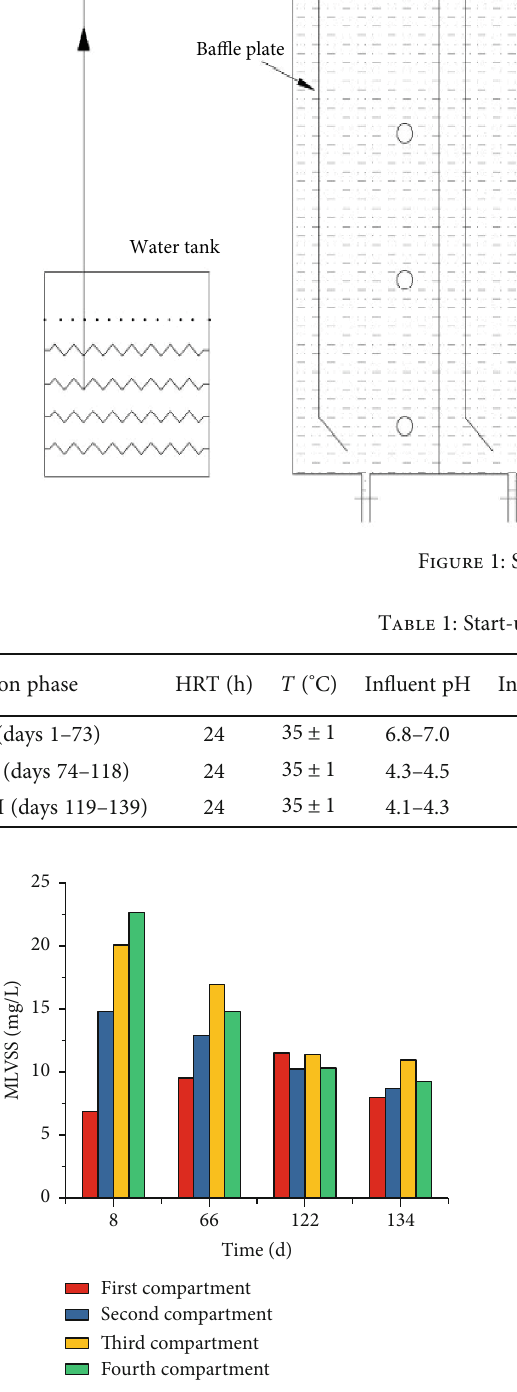
Figure 2: Biomass in each ABR